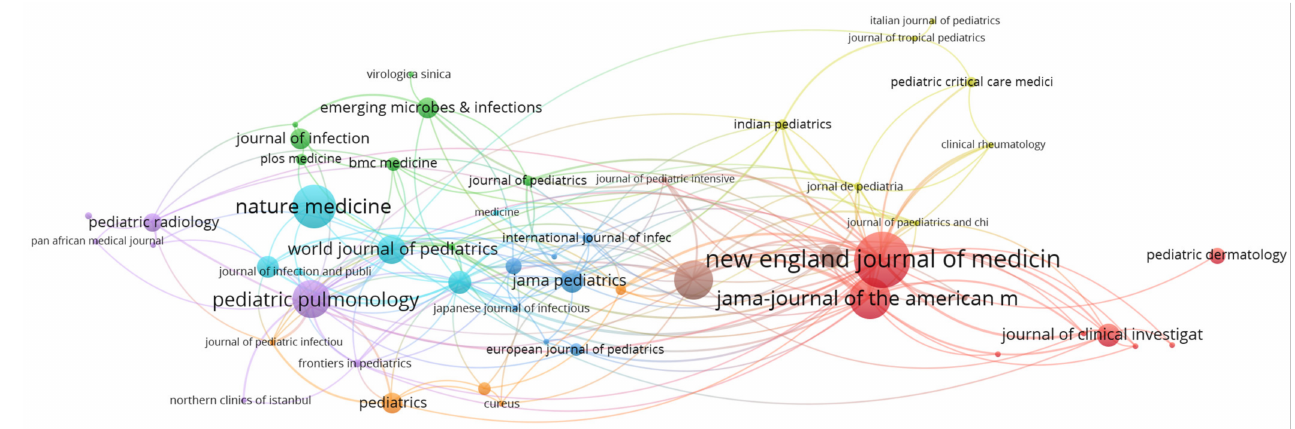
Figure 4. VOSviewer network visualization map of sources (type of analysis: citation, weights— citations, minimum number of documents of a source—2, 55 sources meet the threshold, largest set of connected items—53